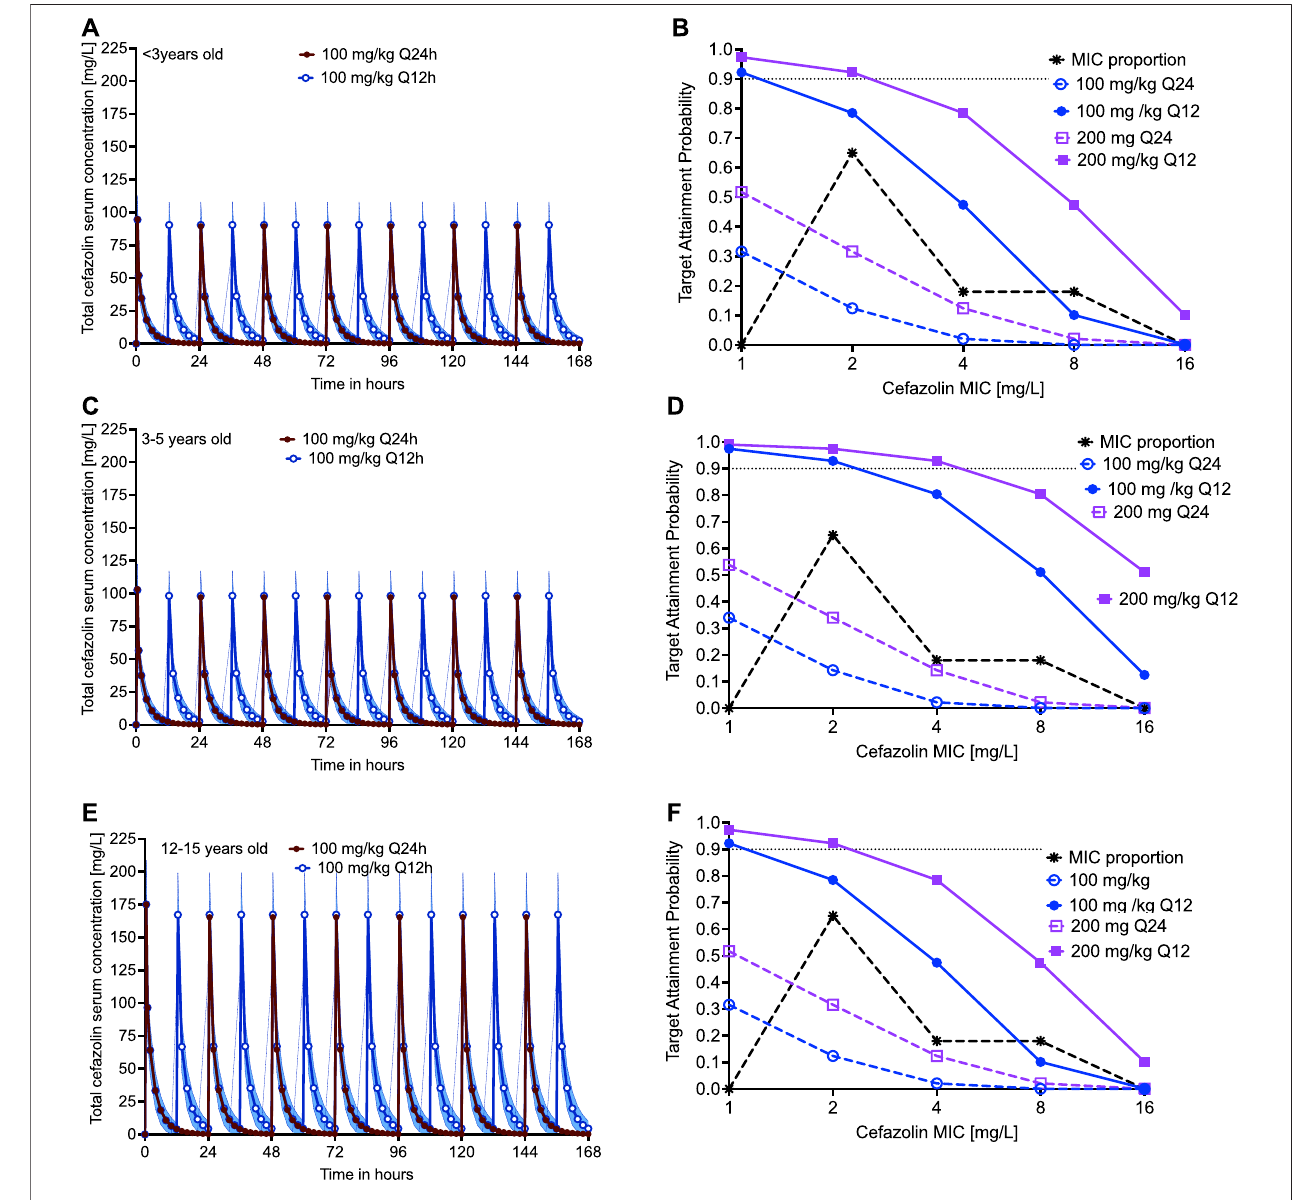
FIGURE5| Cefazolinclinicaldoseandsusceptibilitybreakpoint.TheprobabilityofattainingtheexposuretargetwithagivendosedecreasewithincreaseintheMIC of Mtb. The 7 days simulated PK pro fi le with 100 mg/kg and 200 mg/kg dose is shown for children (A) < 3 years-old, (C) 3 – 5 years-old, and (E) 12 – 15 years-old. The corresponding probability of target attainment, summated over the MIC in clinical strains of Mtb , in these three different age groups, for two different clinical doses administered as once or twice daily is shown in (B) , (D) , and (F) . We proposed the cefazolin susceptibility breakpoint for Mtb as 1 – 2 mg/L.